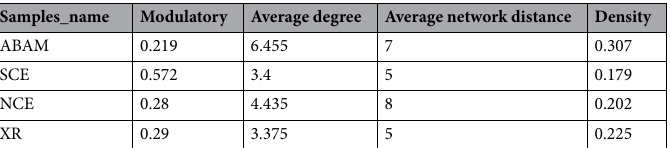
Table 1. Co-occurrence network characteristics calculated for the microbial genera on the three treatments plus XR samples.